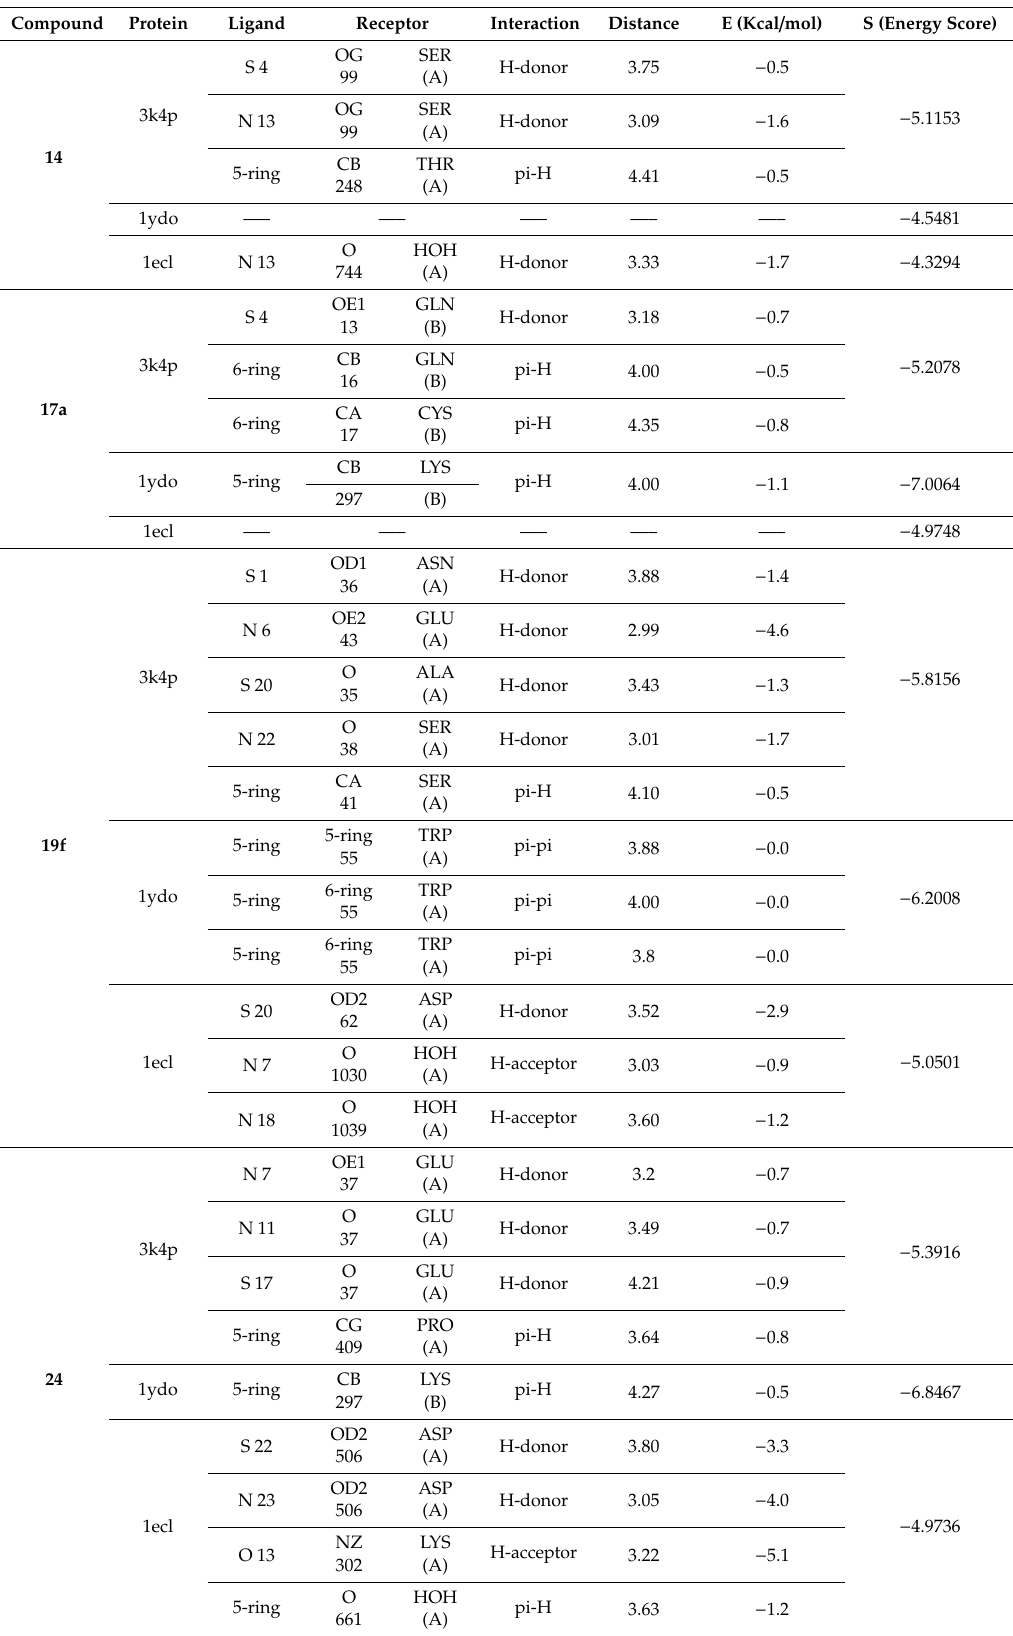
Table 2. The energy score and binding data for all compounds against selected proteins. Compound Protein